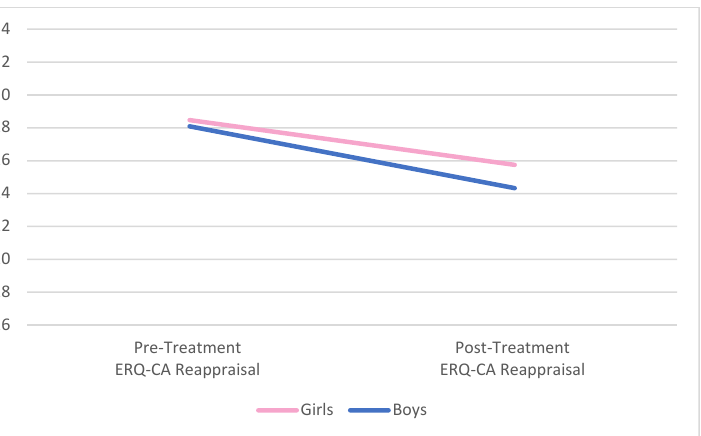
Figure 4. Pre- and post-treatment reappraisal by gender. Notes. No significant differences comparing pre-/post-treatment or comparing boys to girls. ERQ-CA = Emotion Regulation Questionnaire for Children and Adolescents.